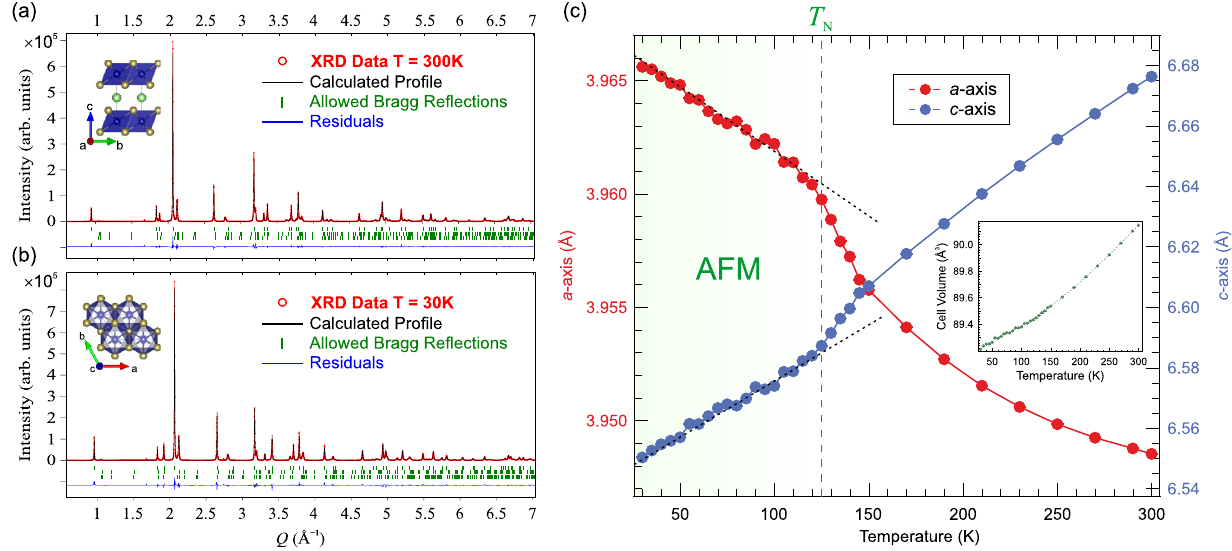
Figure 3. Synchrotron X-ray diffraction (XRD) patterns with the corresponding calculated pattern resulting from Rietveld refinement using spacegroup P 3 m 1 (#164) at ( a ) T lattice parameters as a function of temperature (see also Table 1). Dashed and dotted lines are guides to the eye to indicate a change in temperature dependence (slope) at the antiferromagnetic ordering temperature, 125 K. Inset display the temperature dependence of the trigonal cell T N ≈